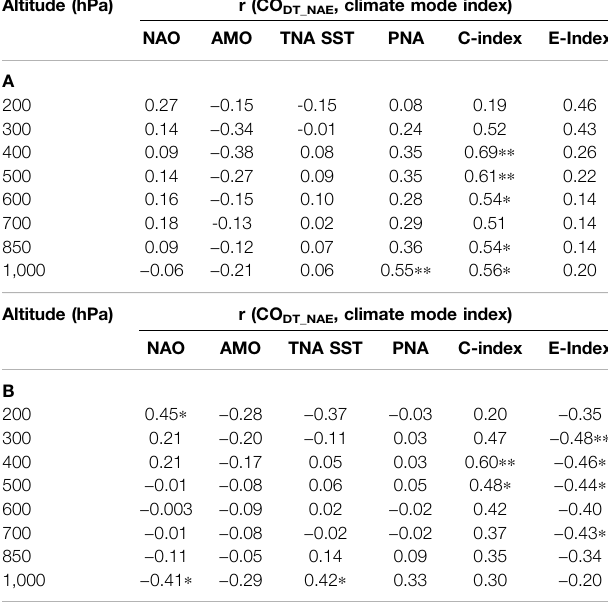
TABLE 4 | (A) Correlation coef fi cients ( r ) between climate mode (NAO, AMO, TNA SST,PNA,C-Index,andE-Index)indicesanddetrendedCOconcentrationsin MAM over the NAE at different altitudes. All the climate indices are averaged from November of year 0 to February of year 1 (NDJF). (B) The same as (A), but all the climate indices are averaged from March to May (MAM) i.e. (A) Correlation between climate mode indices and CO DT_NAE with a time lag. (B) Correlation between climate mode indices and CO DT_NAE without a time